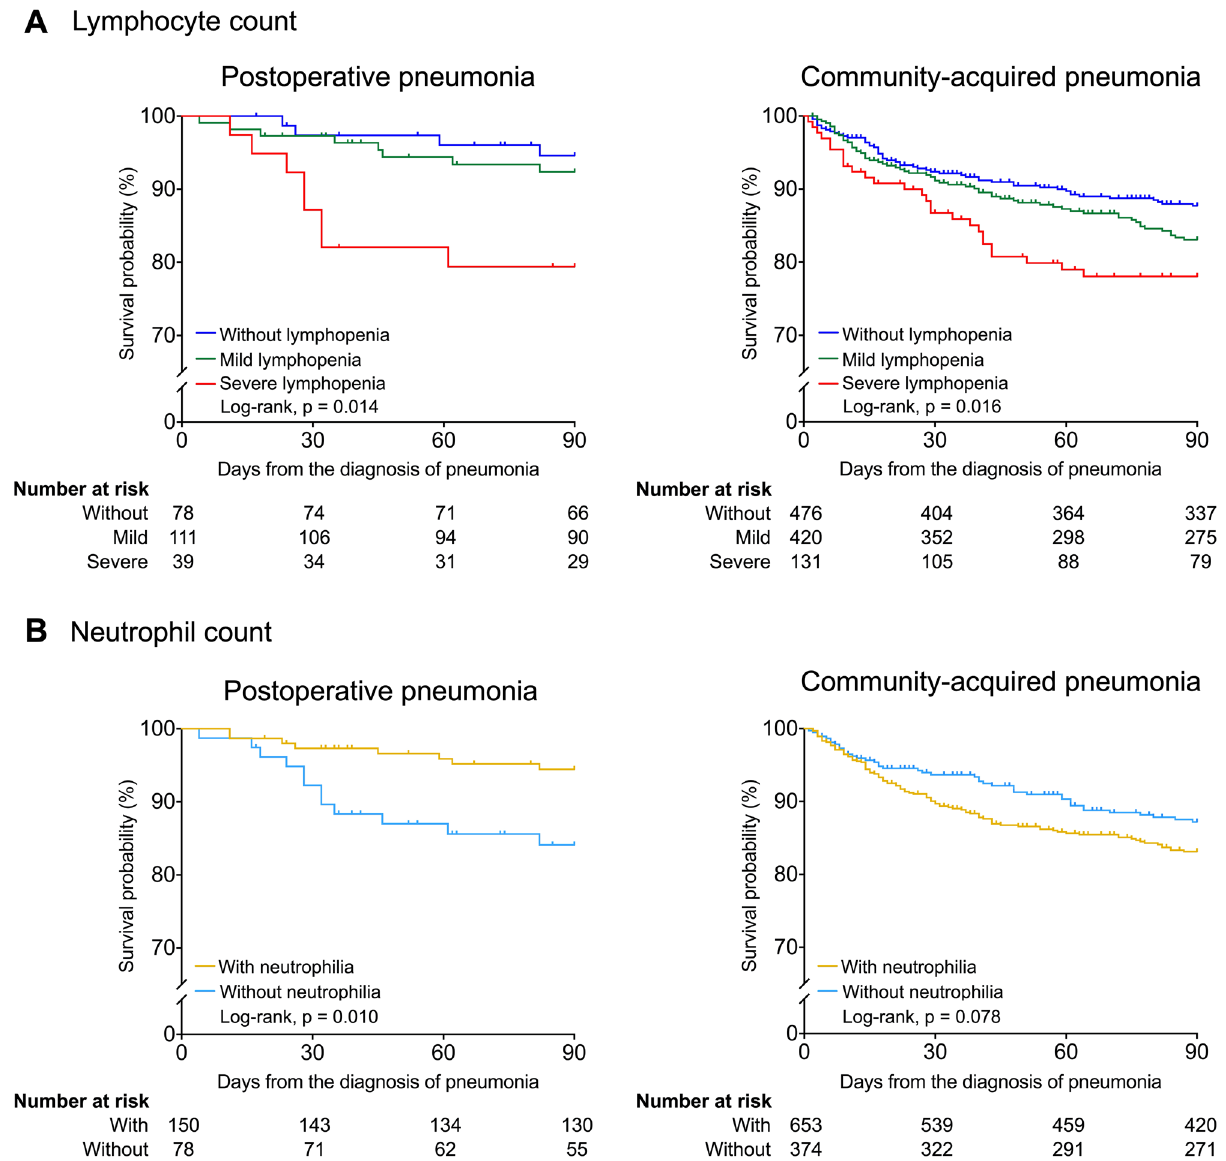
Figure 2. Survival curves for 90-day survival according to lymphocyte and neutrophil counts at pneumonia diagnosis. Kaplan–Meier curves for 90-day survival in patients with postoperative pneumonia and in those with community-acquired pneumonia are shown stratified by absolute lymphocyte count (ALC) ( A ) and neutrophil count (ANC) ( B ) at the time of pneumonia diagnosis. Patients were classified according to ALC as follows: severe lymphopenia, ALC < 0.5 × 10 3 cells/μL; mild lymphopenia, ALC from 0.5 to 0.9 × 10 3 cells/μL; and without lymphopenia, ALC ≥ 1.0 × 10 3 cells/μL. According to ANC, patients with ANC > 7.5 × 10 3 cells/μL were defined as those with neutrophilia, and patients with ANC ≤ 7.5 × 10 3 cells/μL were defined as those without neutrophilia. The P values were calculated using the log-rank